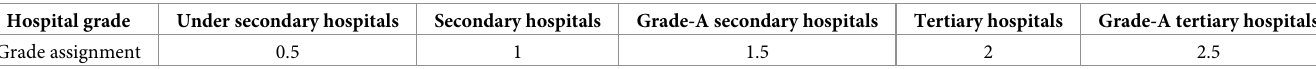
Table 1. Hospital grade